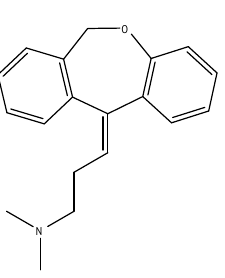
Figure 1. Molecular structure of